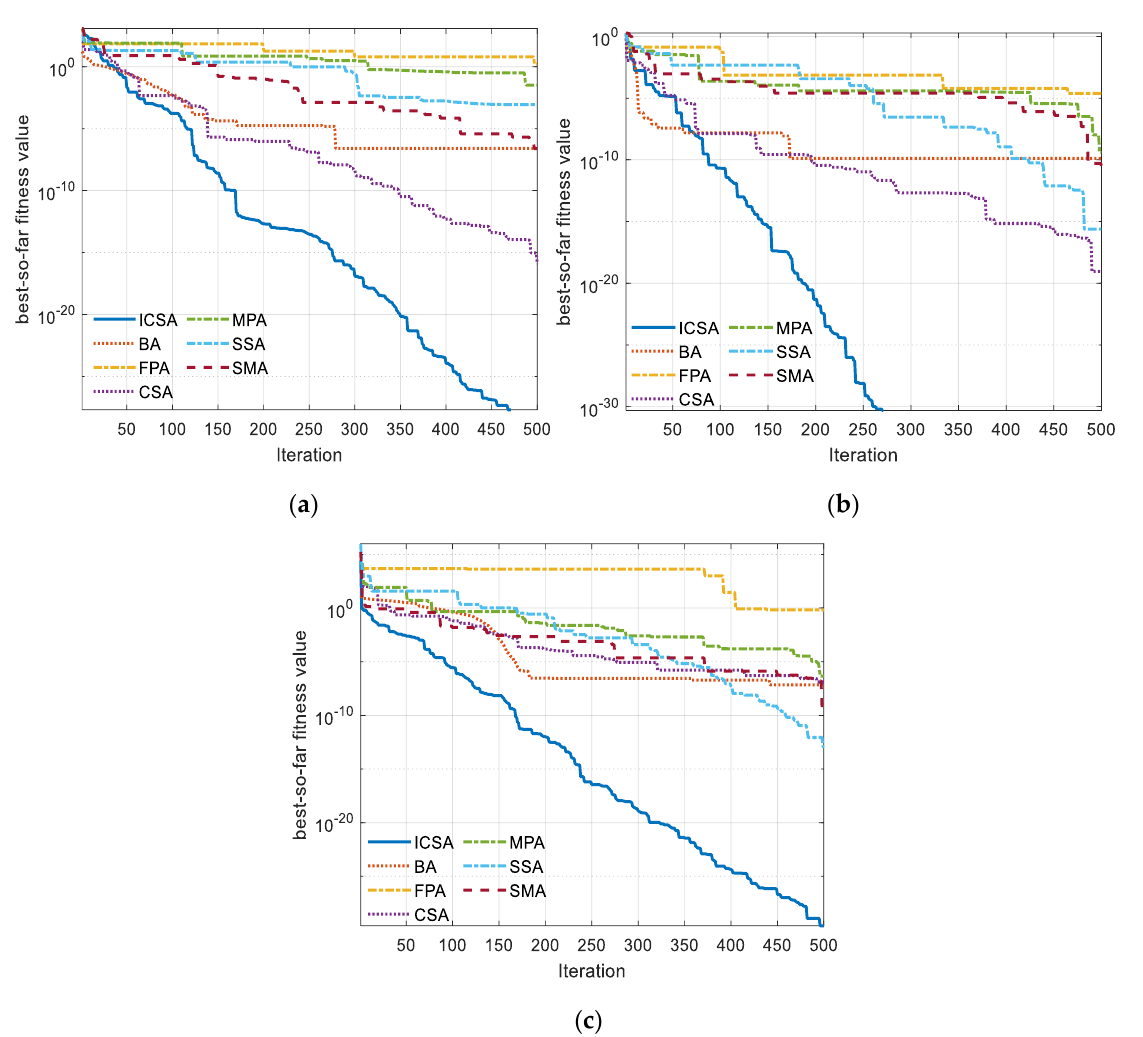
Figure 23. Convergence curve of the algorihms for various test cases: ( a ) Convergence curve for F29; ( b ) Convergence curve